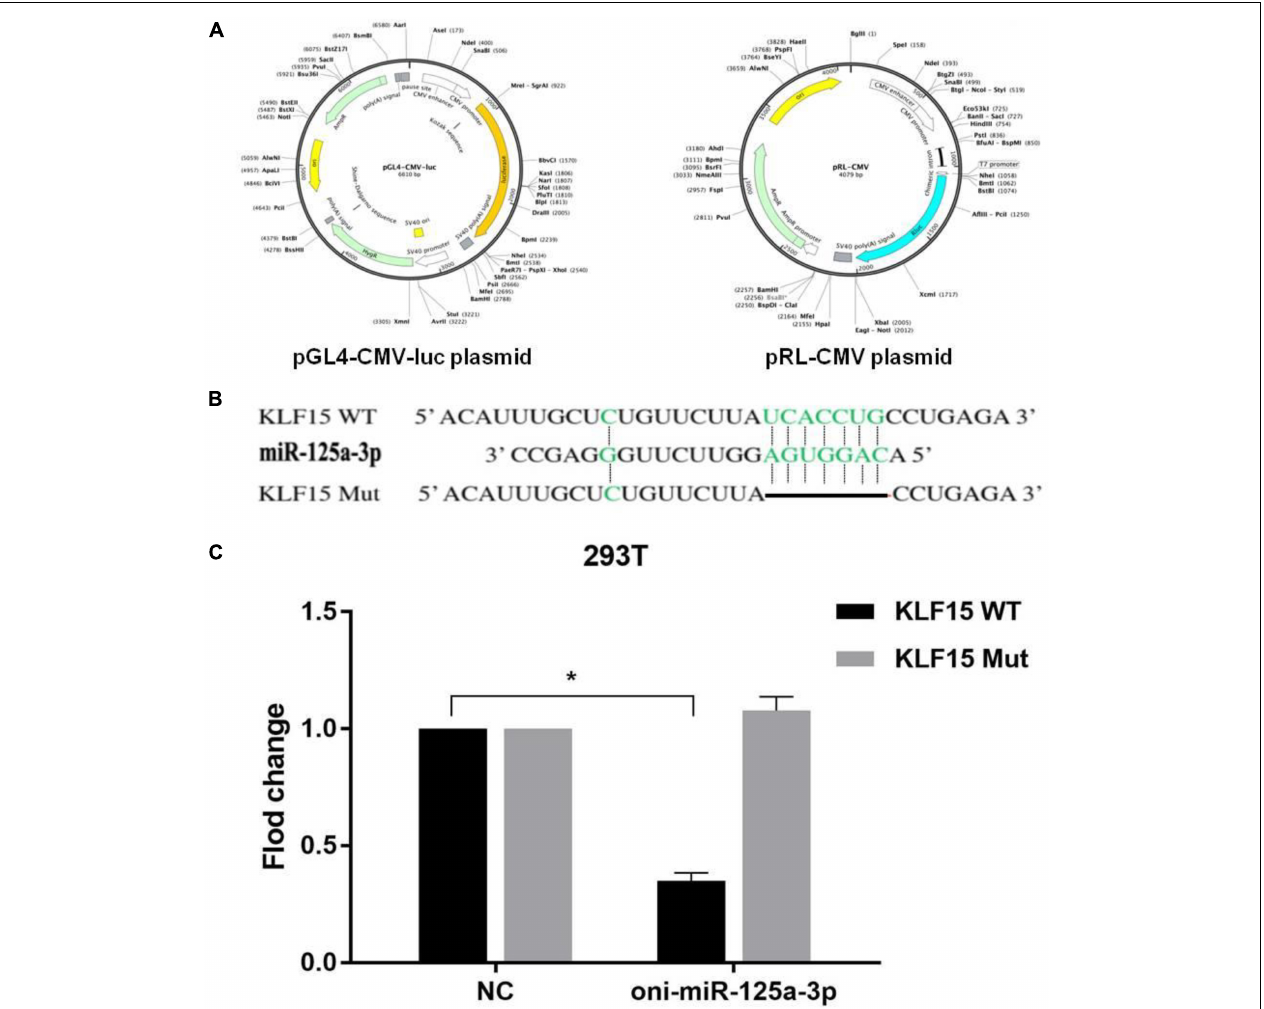
FIGURE 3 | Results of dual-luciferase reporter gene assay. (A) The reporter plasmid of pGL4-CMV-luc and pRL-CMV. (B) miR-125a-3p and KLF15 3 (cid:48) -UTR have matching binding sites. (C) The interaction between miR-125a-3p with the KLF15 3 (cid:48) -UTR. * p < 0.05 significantly different vs. NC.